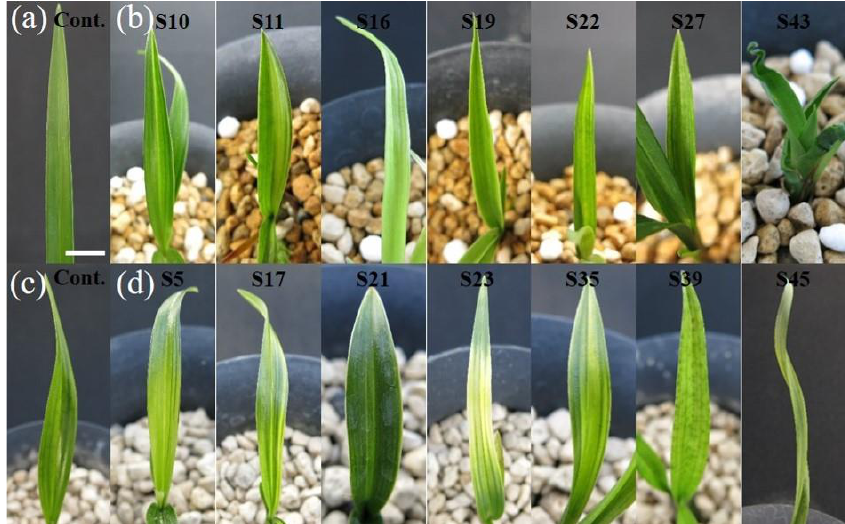
Figure 2. Diverse leaf-color or -shape mutants derived from Cymbidium hybrids RB003 and RB012. ( a ) RB003 control; ( b ) leaf mutants derived from RB003; ( c ) RB012 control; ( d ) leaf mutants derived from RB012. ( b ) indicates S10, S11, S16, S19, S22, S27 (leaf-color mutants), and S43 (leaf-shape mutant), while ( d ) indicates S5, S17, S21, S23, S35, S39 (leaf-color mutants), and S45 (leaf-shape mutant). Scale bar: 1